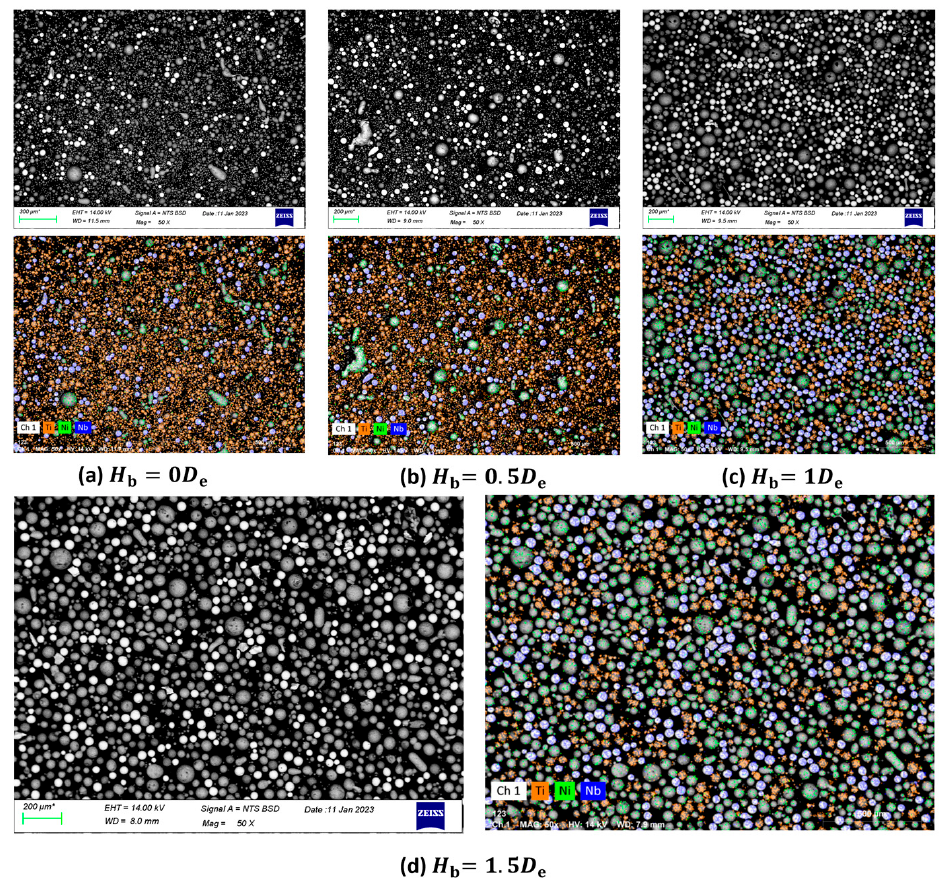
Figure 8. Morphology and element distribution of the mixed powder.